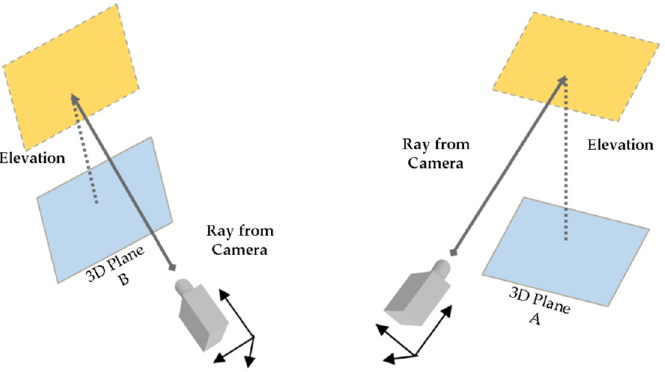
Figure 7 . The process of capturing the virtual elevation between the connection point and any 3D plane in space. plane in space.